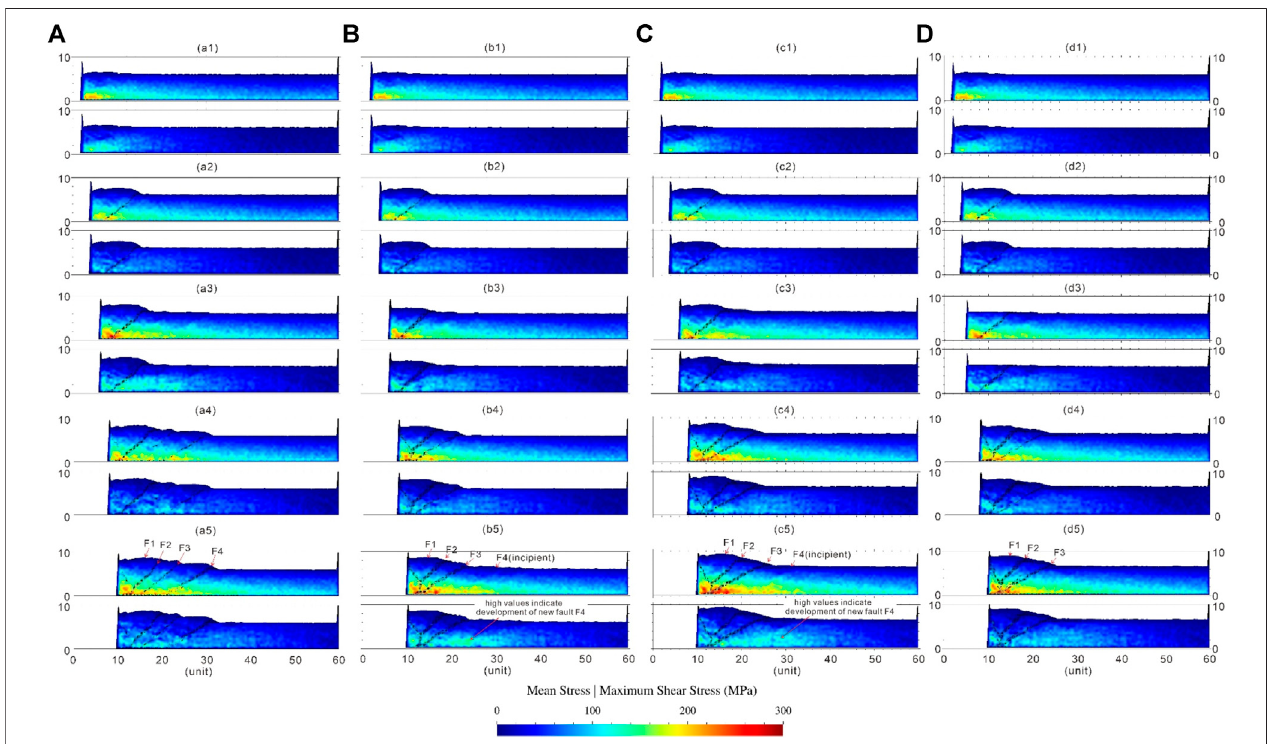
FIGURE 10 | Stress analysis of DEM simulations in Model 1 (A) , Model 2 (B) , Model 3 (C) , and Model 4 (D) . Mean stress (upper fi gure) and maximum shear stress (lower fi gure) are presented after every 2 units shortening. The main fault shapes (shades of black) are assigned to the stress